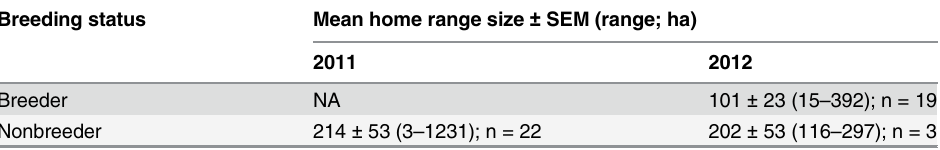
Table 3. Breeding season 95% fixed kernel home range sizes for breeding and nonbreeding